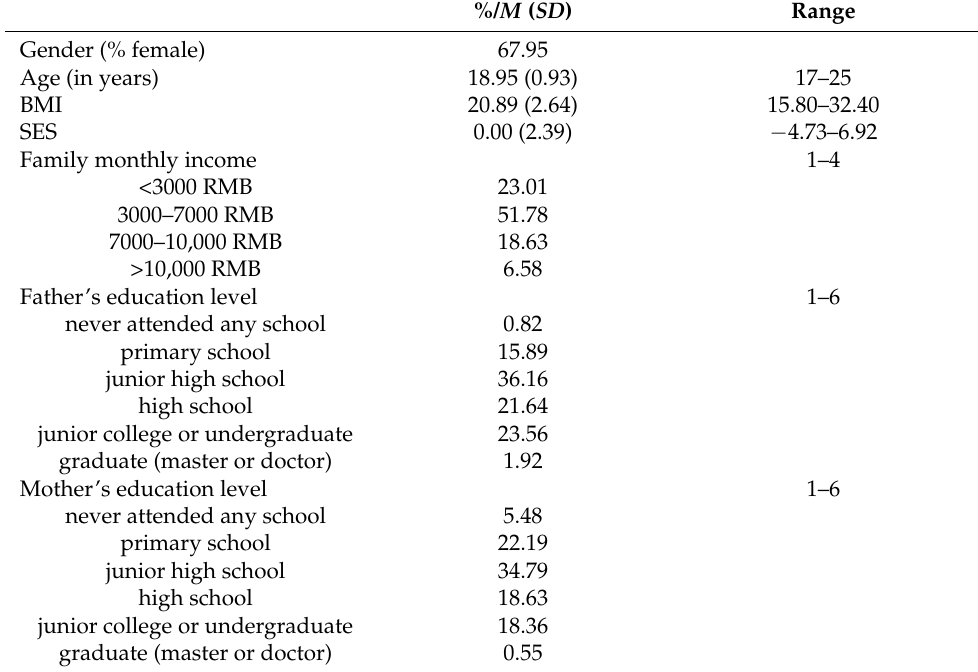
Table 1. Sample characteristics for sociodemographic variables at Time 1 ( N = 365).